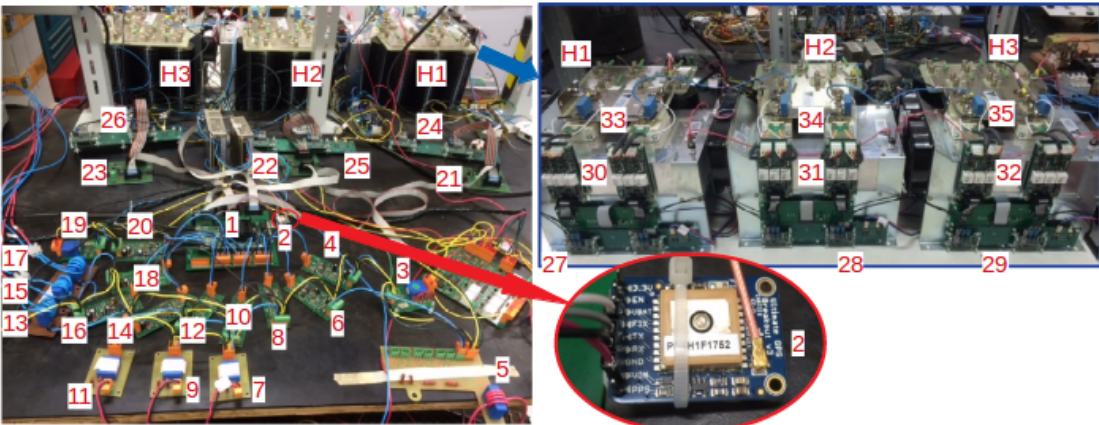
Figure 11. Photo of the experimental setup (whose elements are identified in Table 2) with details of the front side of the inverters and of the GPS